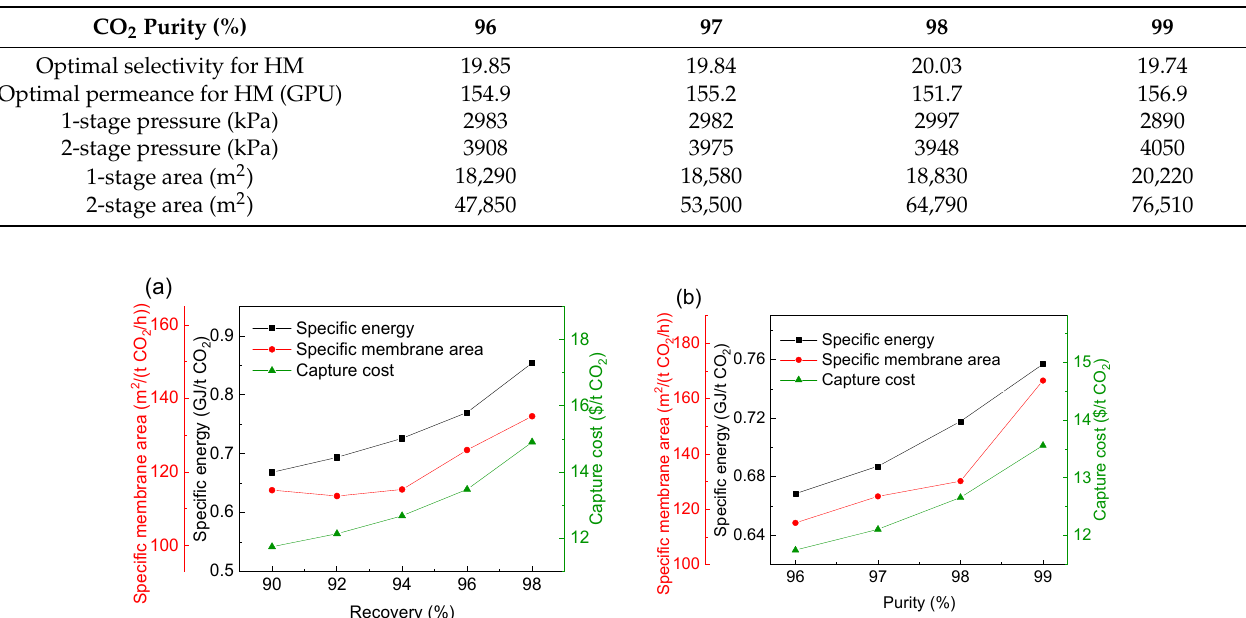
Figure 11. Effect of increasing CO 2 recovery ( a )and purity ( b ) on the CO 2 capture cost, specific power consumption and membrane area in the optimal process.